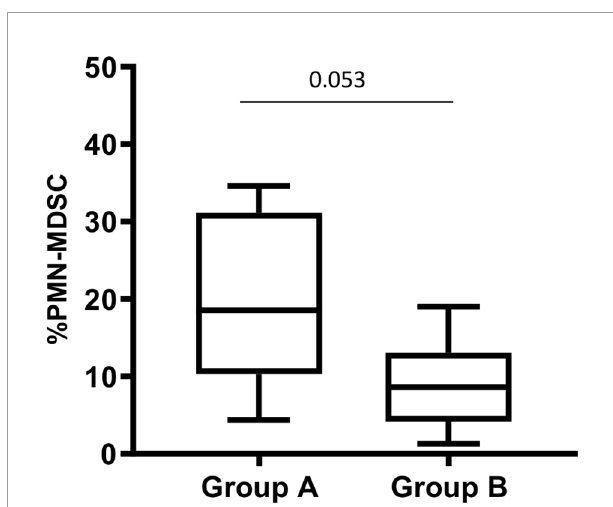
FIGURE 4 | PMN-MDSC frequency is associated with chest X-ray severity score. PMN-MDSC frequency in group A (score 1 and 2) and B (score 3) strati fi ed based on the chest X-ray severity score. The Mann-Whitney test was applied, and the p <0.05 was considered signi fi cant. PMN-MDSC, polymorphonuclear-myeloid-derived suppressor